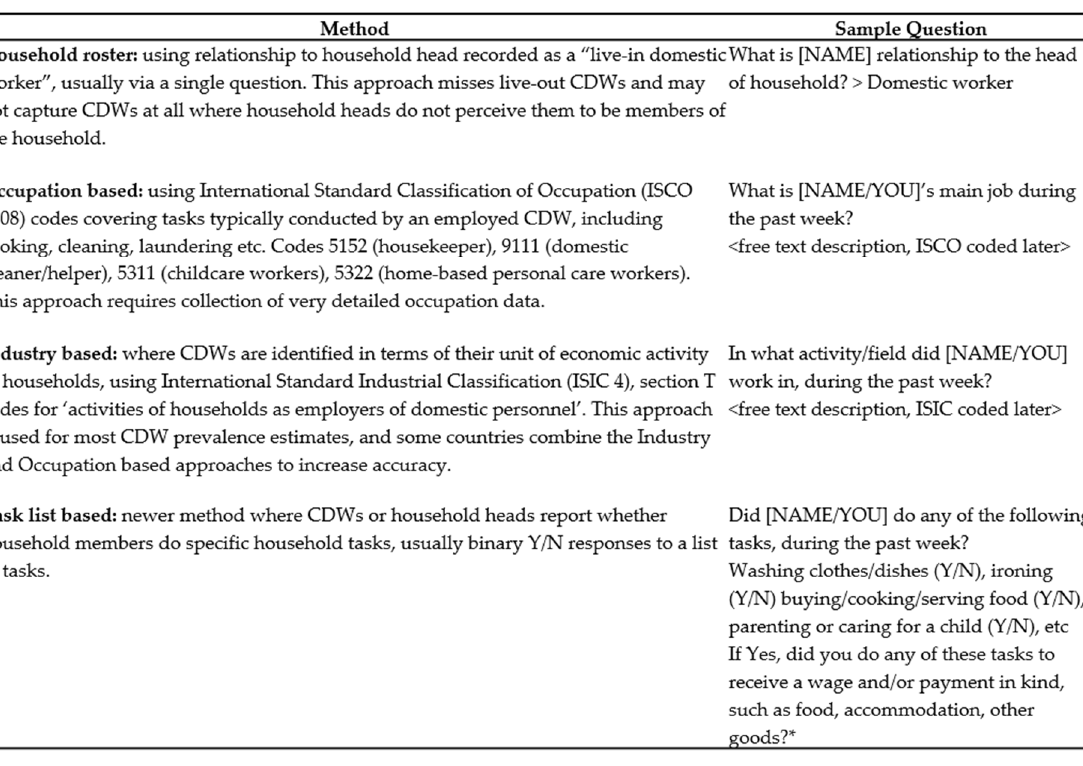
Figure 1. Statistical classification methods for child domestic workers (CDWs) in household surveys. Source: 2017 ILO Practical Guide to Ending Child Labour and Protecting Young Workers in Domestic Work, 2019 Pocock and Zimmerman Child Domestic Worker prevalence in Myanmar and Southeast Asia: Briefing note. * Example question conceived by